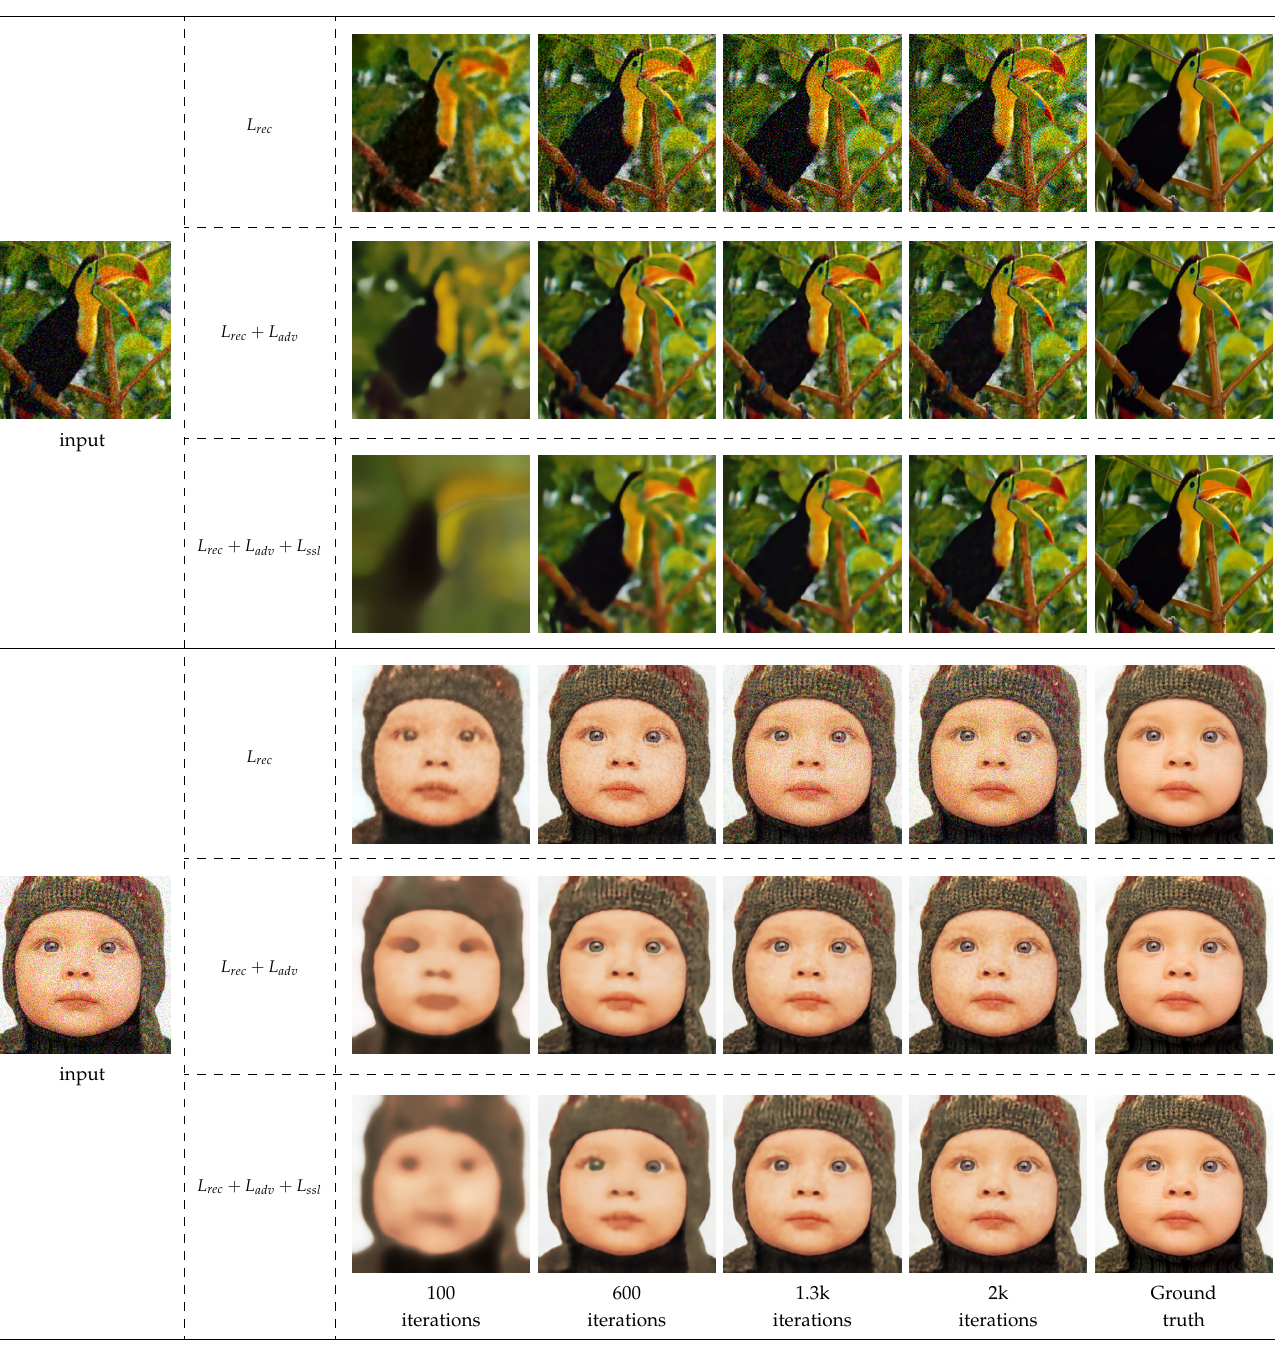
Figure 8. Ablation study for “bird” image and “baby” image in SET5 dataset ( s = 2, σ =